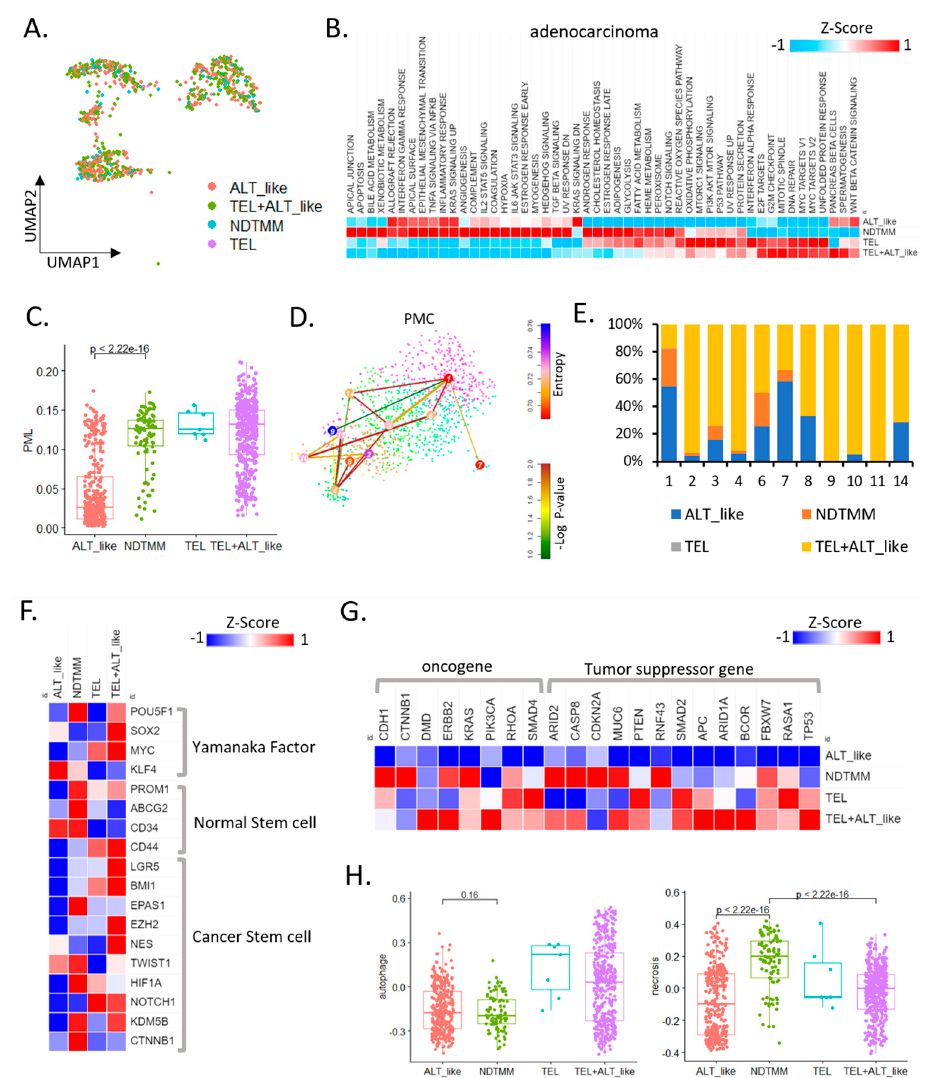
Figure 2. Cancer hallmark and telomere maintenance mechanism (TMM) at the single-cell level. ( A ) UMAP of adenocarcinoma cells with four TMM types (ALT-like, TEL+ALT-like, non-defined telomere maintenance mechanism [NDTMM], TEL). ( B ) Heat map of cancer hallmark of adenocarci- noma cells categorized by four TMM types. ( C ) Boxplot of PML expression in the adenocarcinoma cells categorized by four TMM types. ( D ) tSNE plot of PMC stemness by entropy. ( E ) Bar graph of frequency of TMM types by stemness cluster. ( F ) Heat map of stemness related genes of four TMM types in adenocarcinoma. ( G ) Heat map of oncogene and tumor suppressor gene by four TMM types in adenocarcinoma. ( H ) Boxplot of autophagy and necrosis signature of the four TMM types in adenocarcinoma.